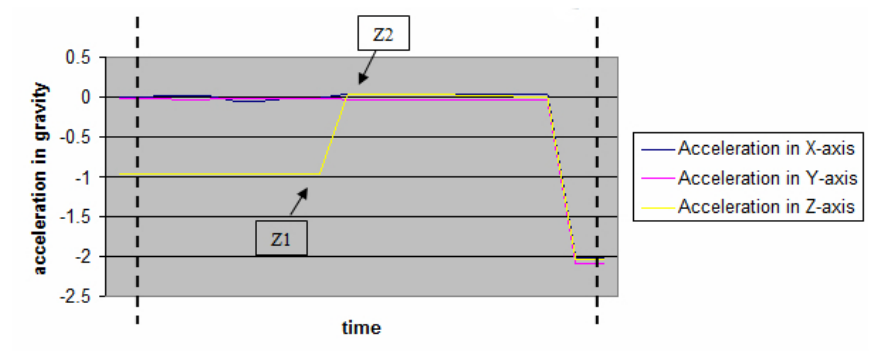
Figure 3. A magnified segment view of the section within the dotted